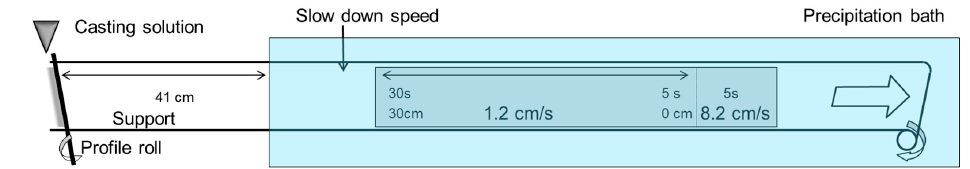
Figure 3. Casting process of gradient samples. The support moves with a constant speed of 8.2 cm/s. The casting solution is applied in front of a profile roll coater, which flattens the casting solution homogeneously to a wet film. After 41 cm distance, the casting solution comes into contact with the precipitation bath, i.e., after a period of 5 s. We call this zero position (0 cm). The speed is then reduced to 1.2 cm/s and therefore the evaporation time slightly increases along the sample up to 30 s at the 30 cm position.